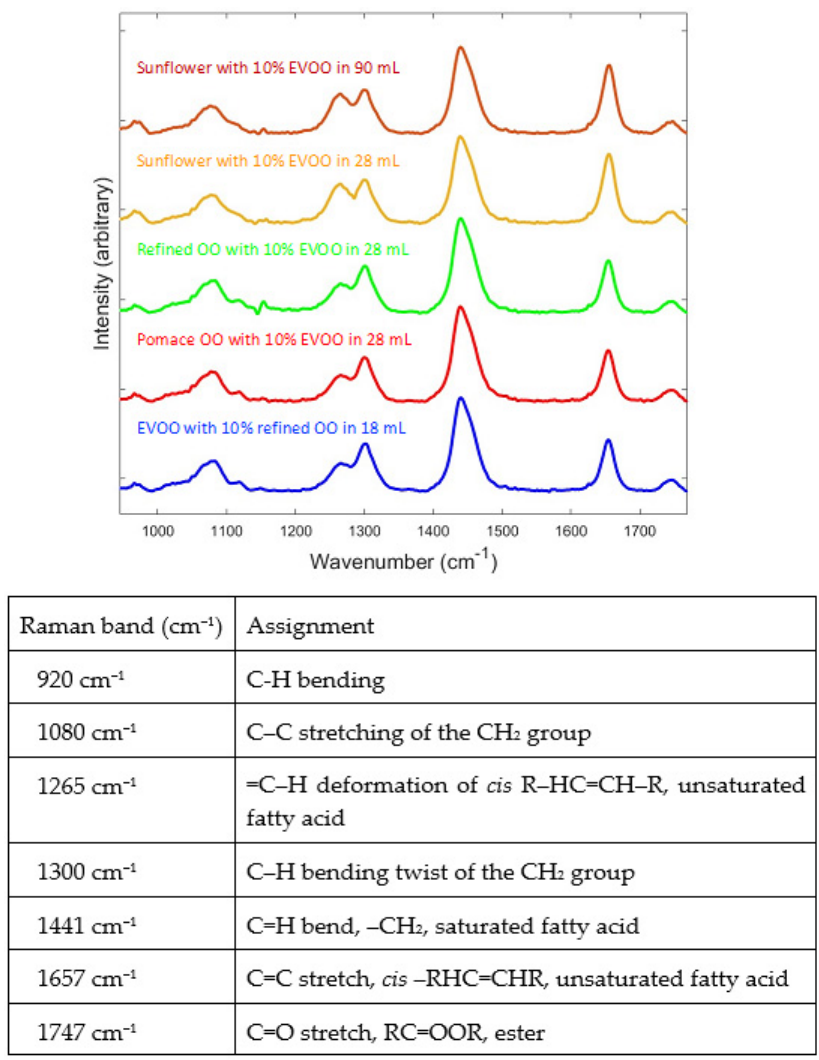
Figure 2. Raman spectra of olive oil collected using SORS directly through bottles. The different authentic extra virgin olive oil–adulterant mixtures are shown in different colours. Spectra are offset in the y -axis so that the features can be more easily observed. Also provided are the origins of the main bands in these oils with assignments taken from [41]. Also highlighted are bands not used within the data processing; these are seen in Supplementary Information.